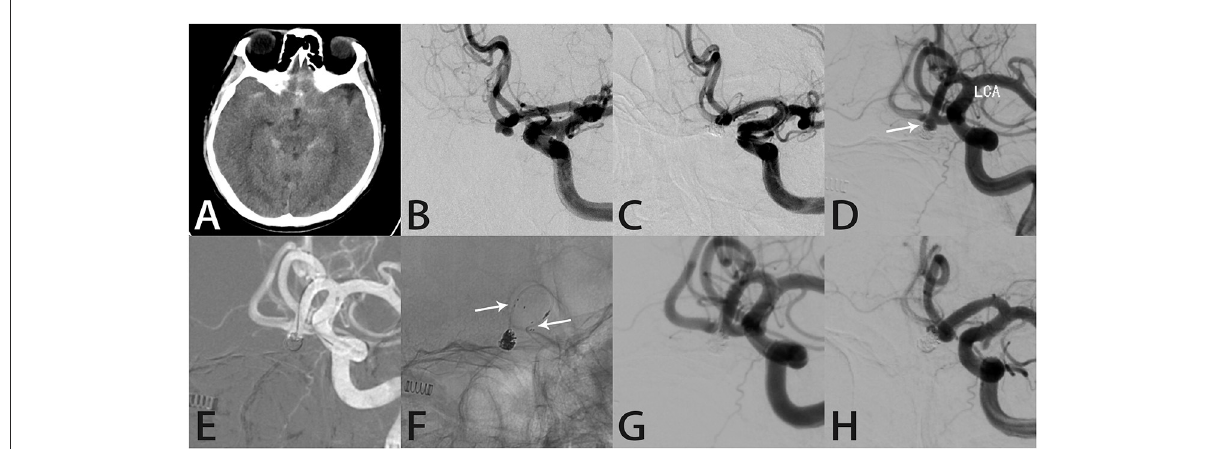
FIGURE2 Images from a 57-year-old man with an anterior communicating artery aneurysm (case 2). (A) Computed tomography showed subarachnoid hemorrhage in the longitudinal and right Sylvian fissures as well as around the brainstem. (B) Preoperative angiography showed an anterior communicating artery aneurysm. (C) The aneurysm was occluded completely after coil embolization. (D) Follow-up angiography 54 months later showed an obvious recurrence in the aneurysm neck (white arrow). (E) During re-treatment, an Echelon 10 microcatheter (Medtronic, Dublin, Ireland) was delivered into the aneurysm sac to place the coils. (F) Intraprocedural angiography showed the three radiopaque markers (white arrows) at the proximal and distal ends of the Atlas stent (3.0 × 15mm) and the coils within the aneurysm sac. (G) Angiography immediately after the procedure showed the aneurysm was occluded completely. (H) Follow-up angiography 8 months later showed complete aneurysmal occlusion and parent artery patency.